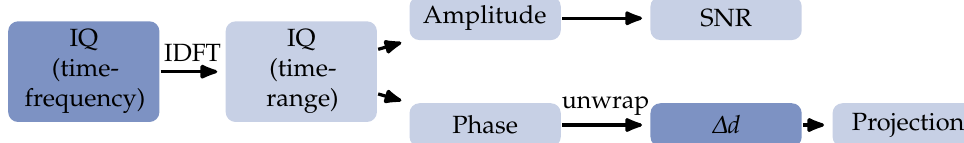
Figure 2. GBR processing of complex raw measurements to projected displacements.